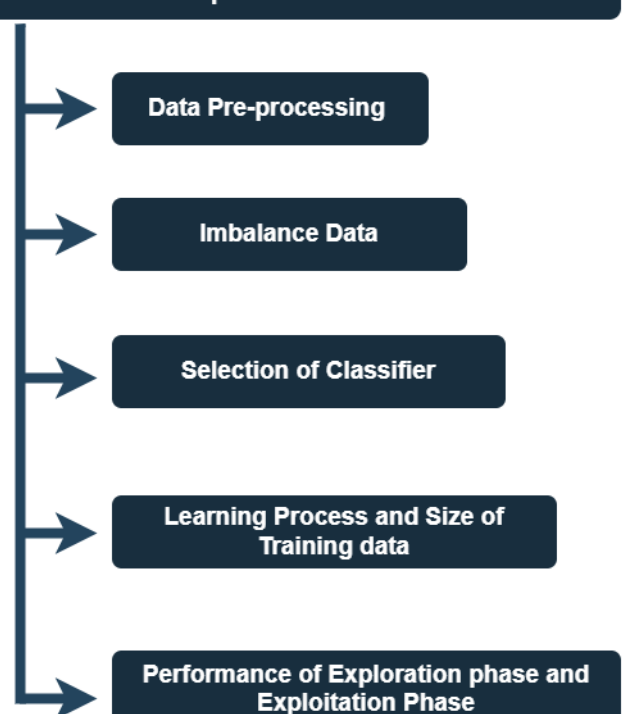
Figure 11. Implementation challenges of nature-inspired algorithms . Data Pre-processing.